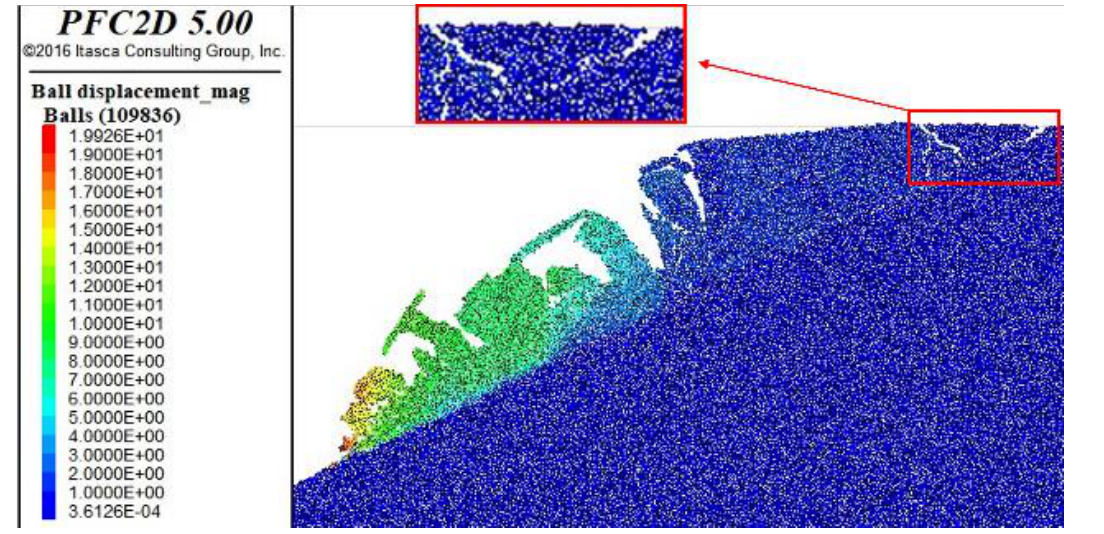
Figure 10. Displacement diagram in the later stage of collapse.